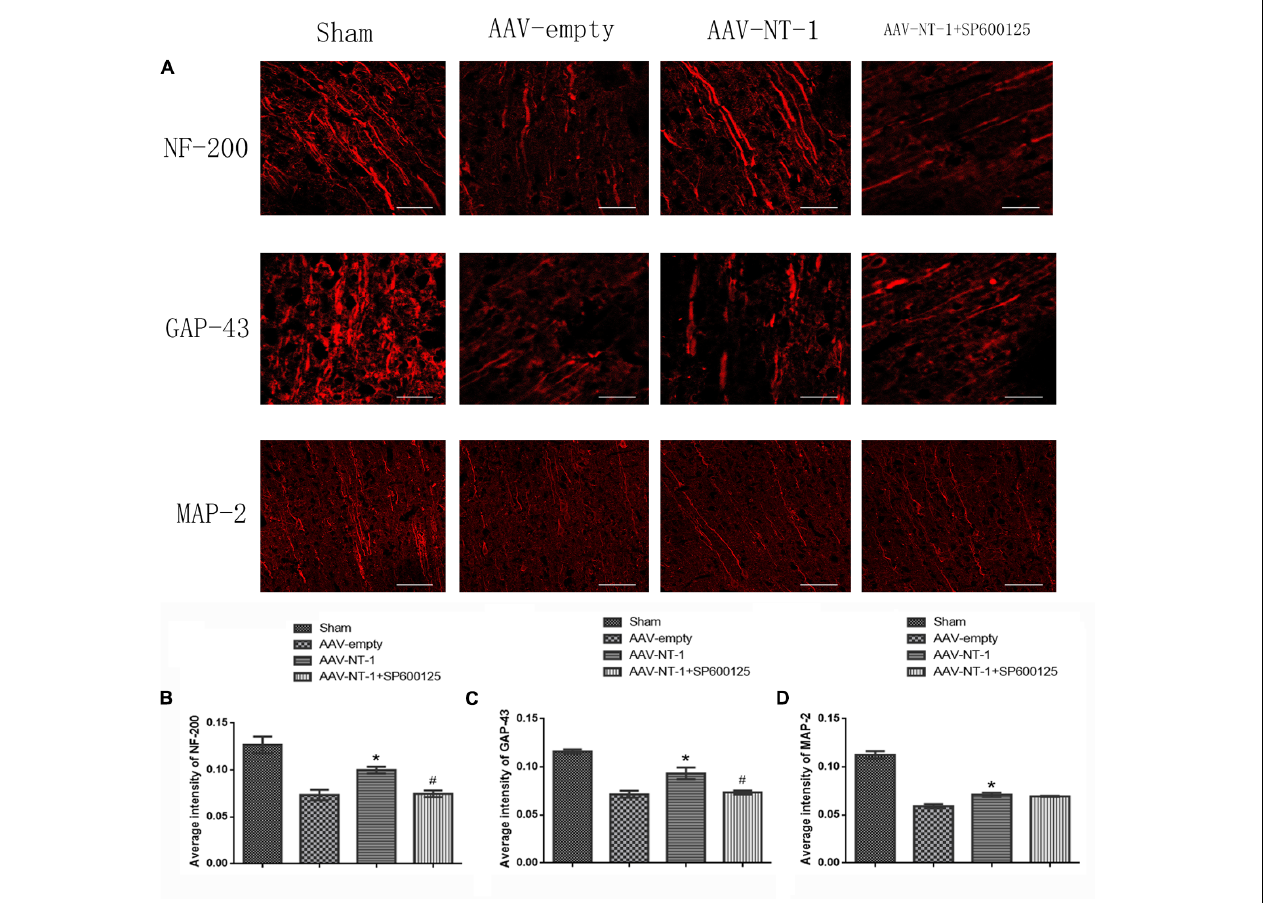
FIGURE 9 | Images of immunofluorescence staining in each group. (A) Pictures represent the expression of NF-200, GAP-43 and MAP-2, respectively. Rats in each group were sacrificed at Day 14 after the MCAO. Scale bar = 50 µ m. (B) Immunofluorescence analysis of NF-200 ( n = 3), ∗ p < 0.05, as compared with the AAV-empty group, # p < 0.05, as compared with the AAV-NT-1 group. (C) Immunofluorescence analysis of GAP-43 ( n = 3), ∗ p < 0.01, as compared with the AAV-empty group, # p < 0.01, as compared with the AAV-NT-1 group. (D) Immunofluorescence analysis of MAP-2 ( n = 3), ∗ p < 0.05, as compared with the AAV-empty